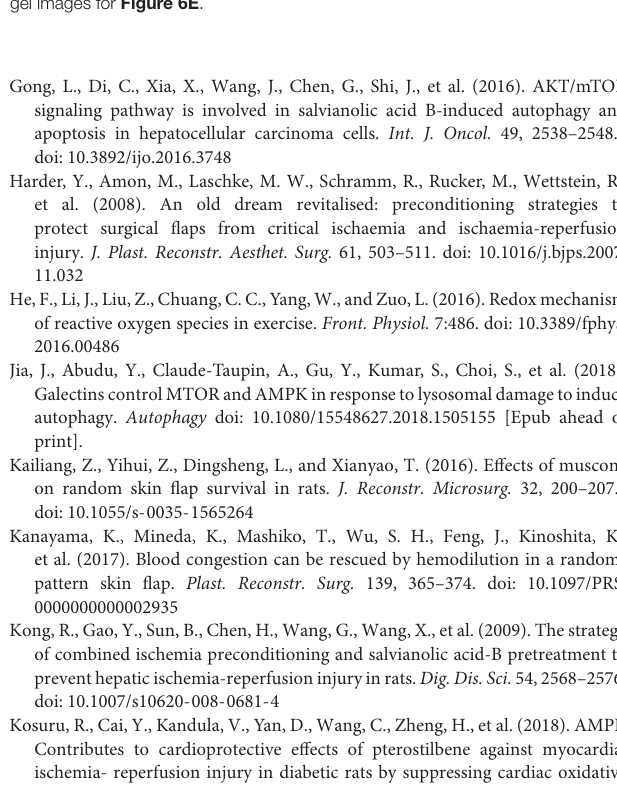
FIGURE S1 | Original western blot images for comparison of the Control and Sal B groups. (A) The original gel image for Figures 2E–G . (B) The original gel images for Figures 3C–E . (C) The original gel image for Figures 4C–E . (D) The original gel image for Figures 5E,F . FIGURE S2 | Original western blot images for comparison of the Sal B and Sal B + 3MA groups. (A,B) The original gel image for Figure 6C . (B,D) The original gel images for Figure 6E